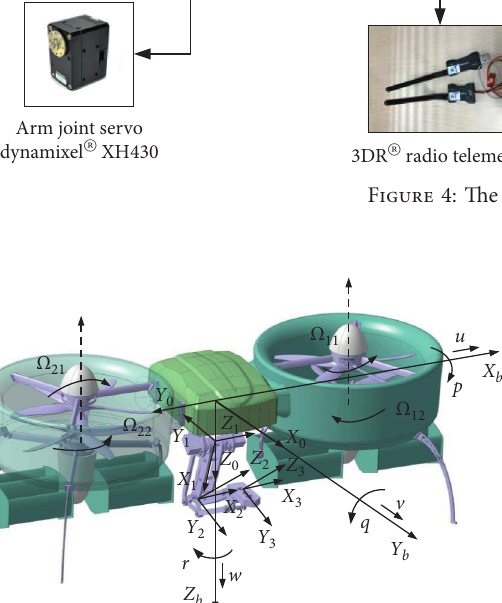
Figure 5: The coordinate system of the aerial